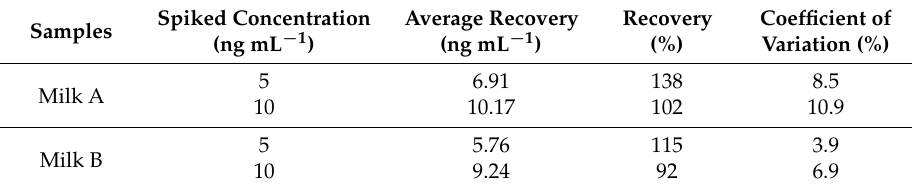
Table 2. Recoveries and precision of CLB in spiked milk samples ( n = 3).